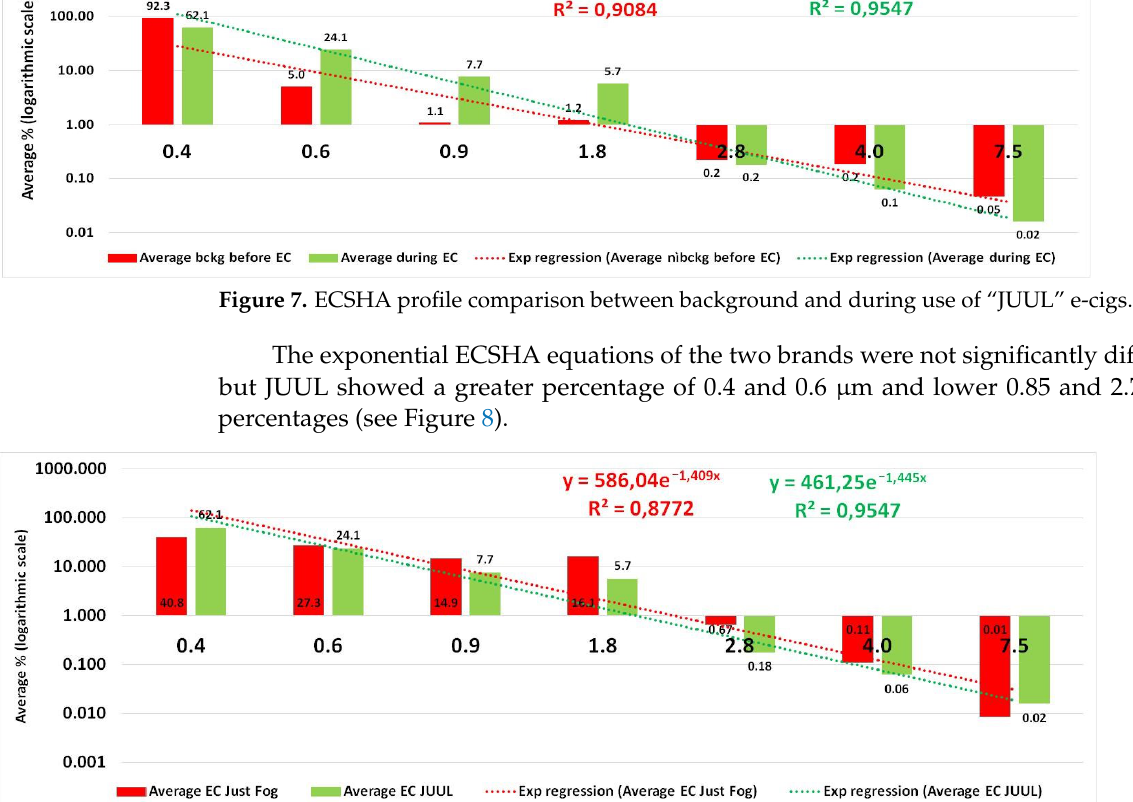
(6.2 and 168, respectively). The Pearson correlation was good (R = 0.953), and the Wil-